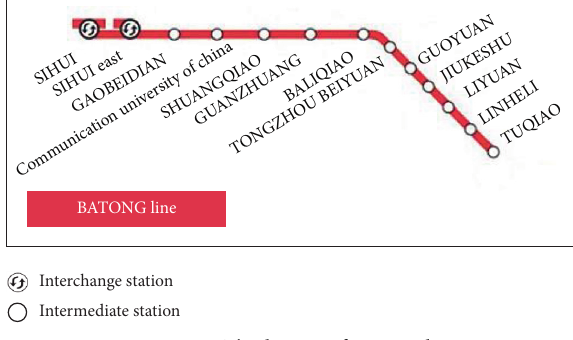
Figure 12: The layout of Batong line.